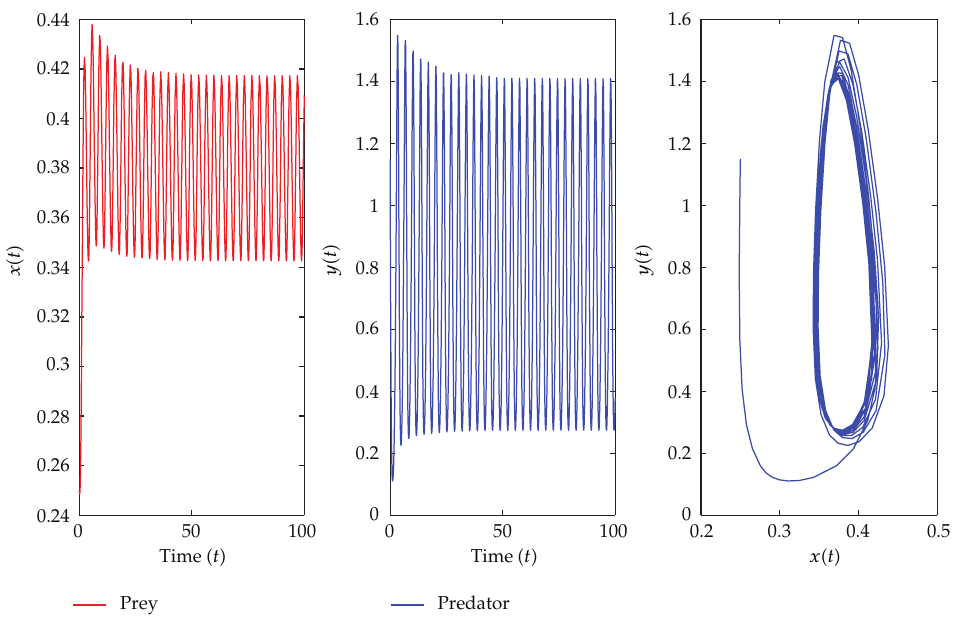
Figure 4: E (cid:7) 0 . 3333 , 0 . 6666 (cid:8) is unstable when τ 2 (cid:6) 0 . 75 > τ 10 (cid:6) 0 . 7311 with initial value 0.25,